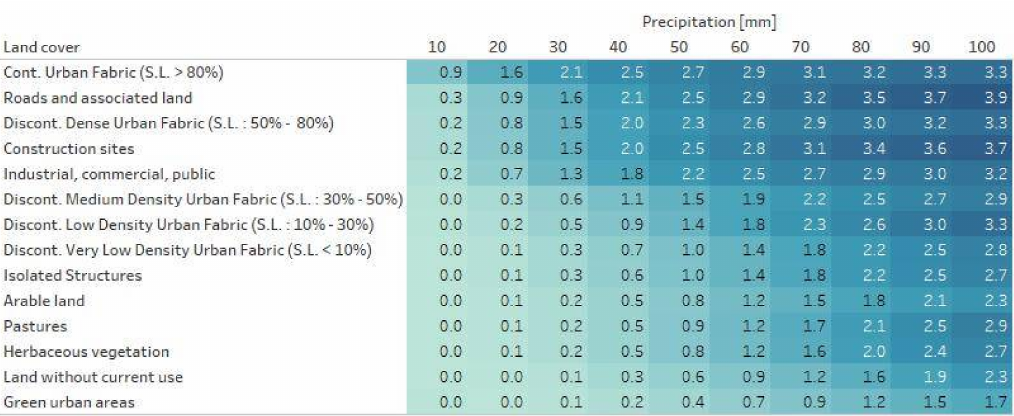
Figure 4. The highlight matrix of the mean water level [cm] according to the simulated precipitation height [mm].